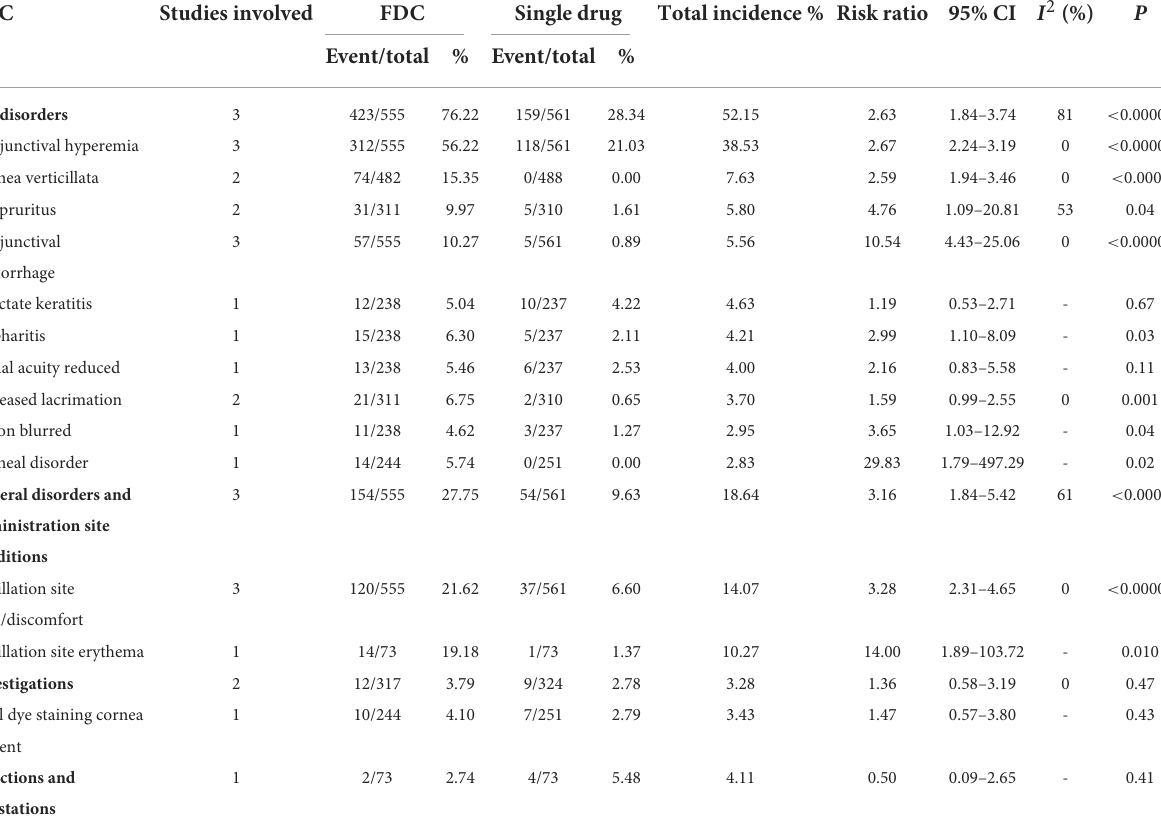
TABLE 4 Comparison of adverse events grouped by SOC between netarsudil/latanoprost FDC and latanoprost.